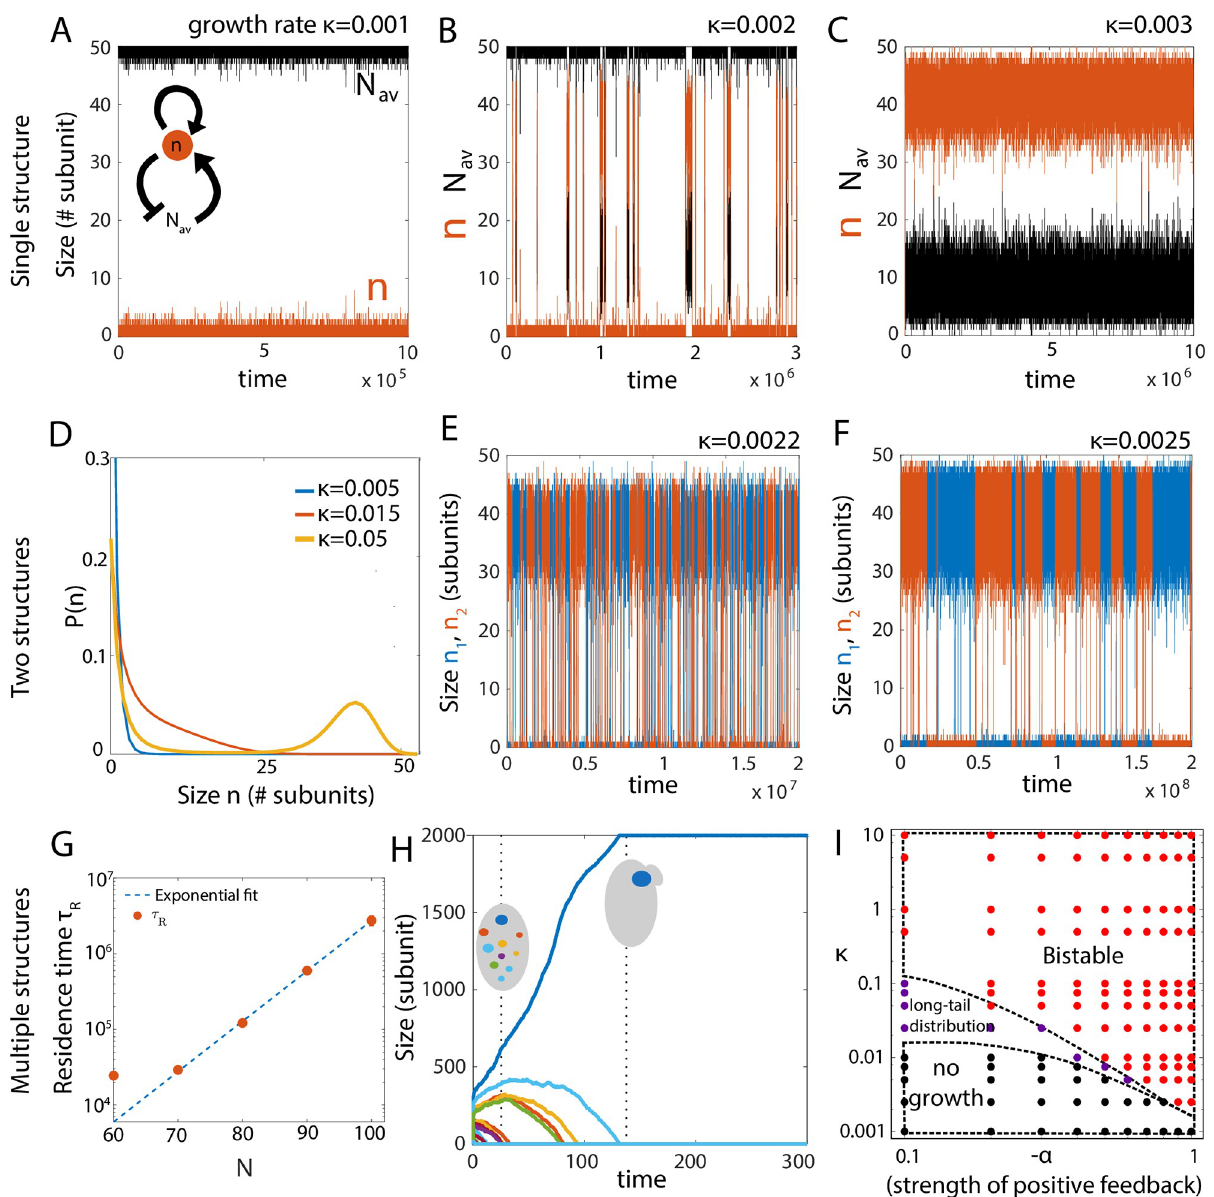
Fig 6. Bistable size distribution emerges from autocatalytic growth. Bistability in a single structure growth occurs in a range of κ value. (A) The structure does not grow substantially for very small growth rates ( κ < κ � ) but (B) it shows bistability and bimodal size distribution in an intermediate range of growth rates. (C) For growth rates higher than a critical value κ > κ c , the structure takes up almost the whole pool and grows to be very large as expected in autocatalytic growth. Parameters for A-C: N = 50, α = − 1, β = 0. (D) Probability distribution for the size of two identical structures ( κ 1 = κ 2 = κ = k + / k − ) assembled via autocatalytic growth. The structures do not grow at very low growth rates, leading to an exponential distribution peaked at 0. At high κ , the size distribution is bistable. Parameters: N = 50, α = − 0.2, β = 0. (E-F) Dynamics of the size of the two structures in the bistable regime at two different growth rates κ = 0.0022 (E) and κ = 0.0025 (F). Parameters: N = 50, α = − 1.0, β = 0. (G) Residence time ( τ R ) of a single structure increases exponentially with increasing concentration of subunits. Dashed line—exponential fit, solid circles—simulation data. (H) Stochastic selection of a single structure when multiple structures compete for a limiting subunit pool, for α + β < 0 and high subunit concentration. Here, the residence time of a single structure becomes seemingly infinite, so the stochastically chosen large structure can remain stable for long timescales. Parameters: N = 2000, κ = 0.0125, α = − 1, β = 0, and number of structures = 20. (I) State diagram of the system, showing different growth regimes as a function of κ and the strength of positive feedback, − α (with β = 0). By increasing κ at any non-zero value of − α , the system transitions from a “no-growth” state (black dots), can be very large to effectively to a “shoulder” state (purple dots) at intermediate κ , and finally a bistable state (red dots) for high κ . At very high κ , τ R give rise to a single-structure. Increasing the strength of positive feedback promotes a bistable state at smaller κ . Parameters: β = 0, V = 1 and N = 50.